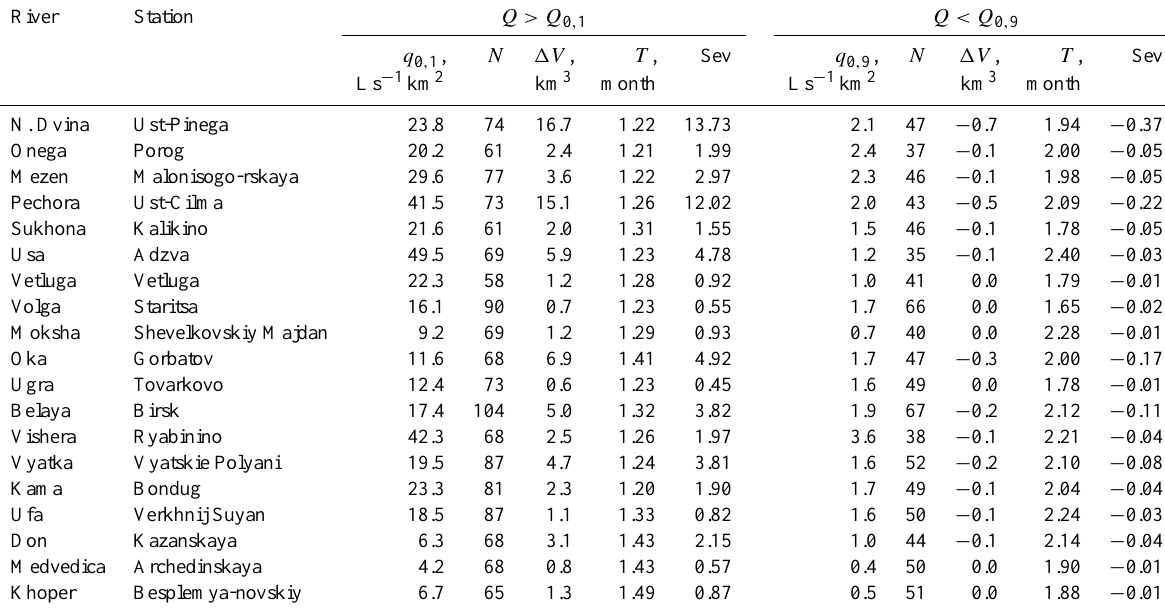
Table 1. Characteristics of extreme events for 10 and 90% probability threshold values.